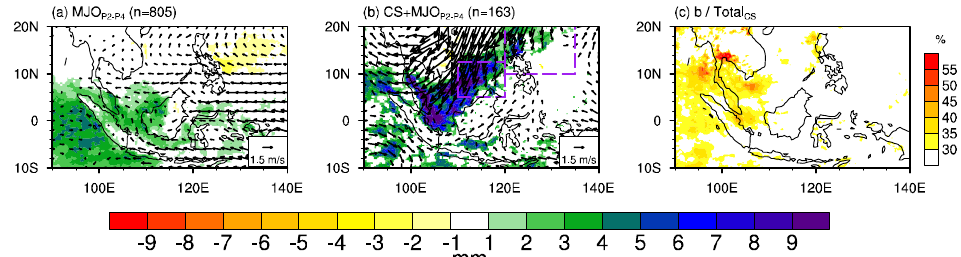
Figure 10. Same as Figure 5, but during phases 2−4 of the MJO.